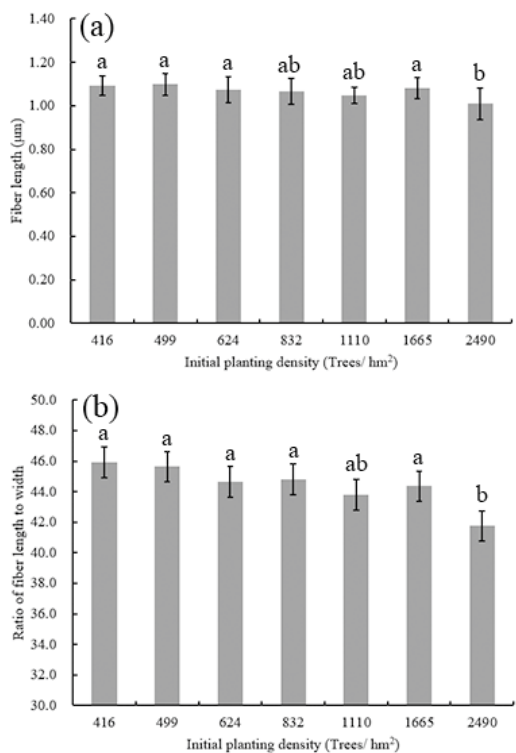
Figure 2. The effects of initial planting density on FL and FL/FW of triploid white poplar: ( a ) The effects of initial planting density on the FL. ( b ) The effects of initial planting density on the FL/FW. Lowercase letters indicate significance at the p < 0.05 level.